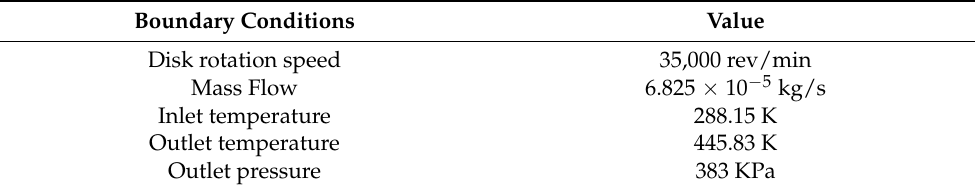
Figure 5. Geometry and finite element model of the centrifugal compressor disk: ( a ) The geometry of the centrifugal compressor disk; ( b ) The finite element mesh of the centrifugal compressor disk model.